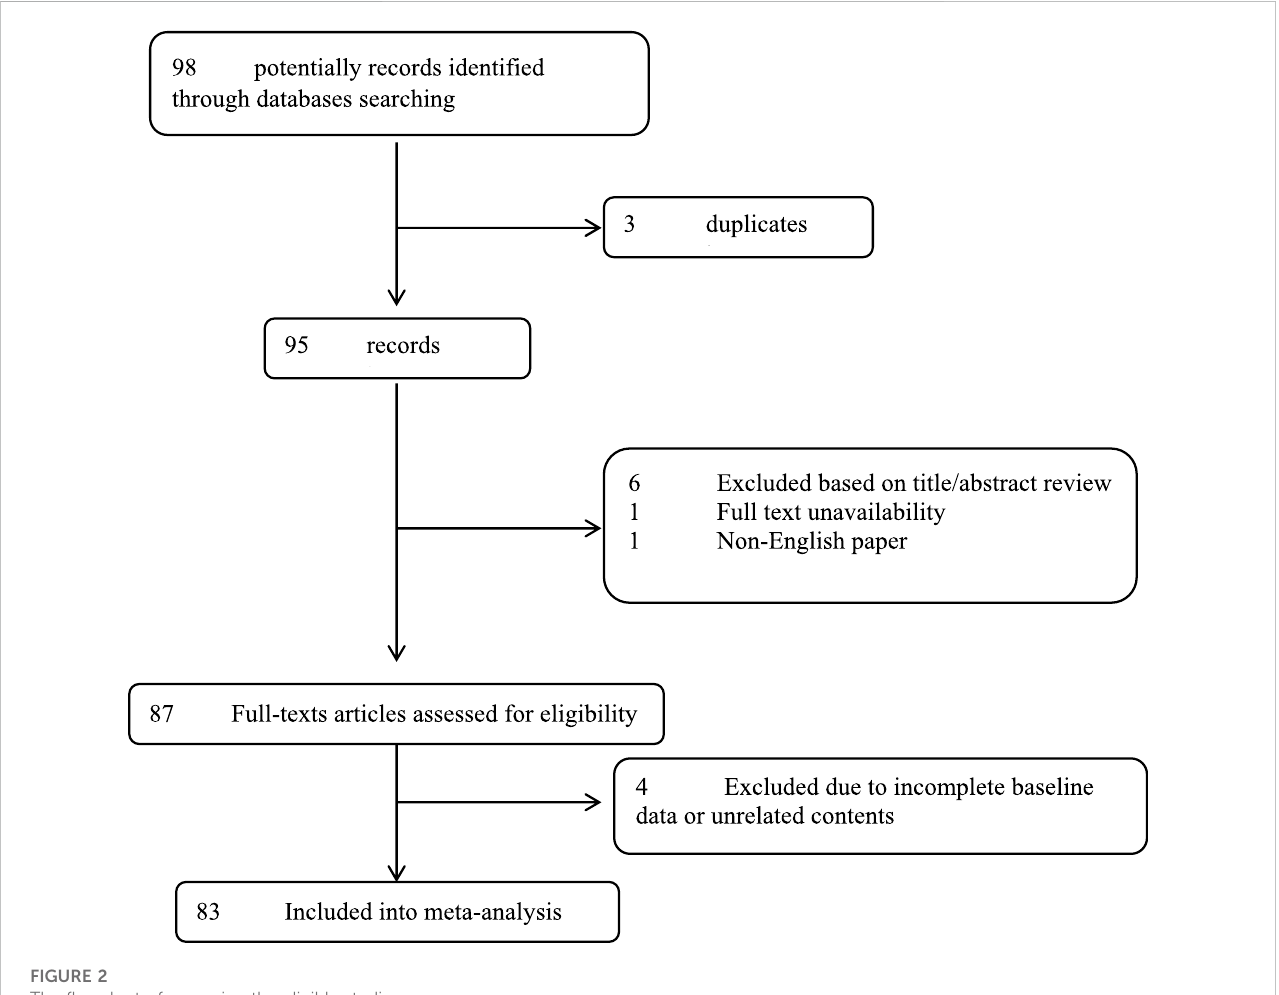
FIGURE 2 The fl owchart of screening the eligible